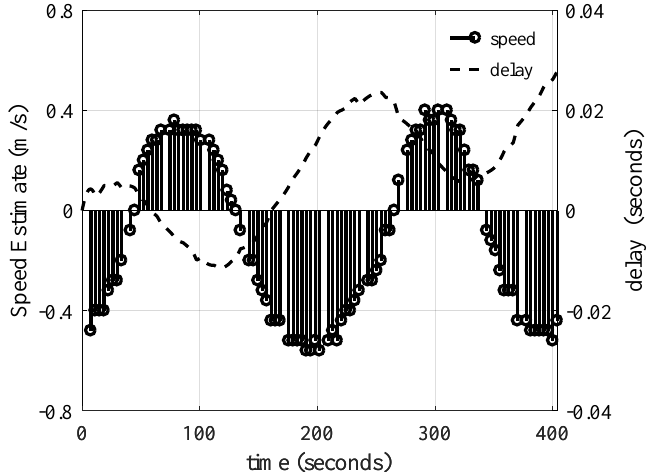
Figure 13. Output of the velocity estimation algorithm, and resulting symbol delay correction at the 4-km range. The transmit vessel was moving at approximately 1 knot in small concentric circles with a radius below 50 m such that the boat was moving towards the receiver for a period of time, and then away from the